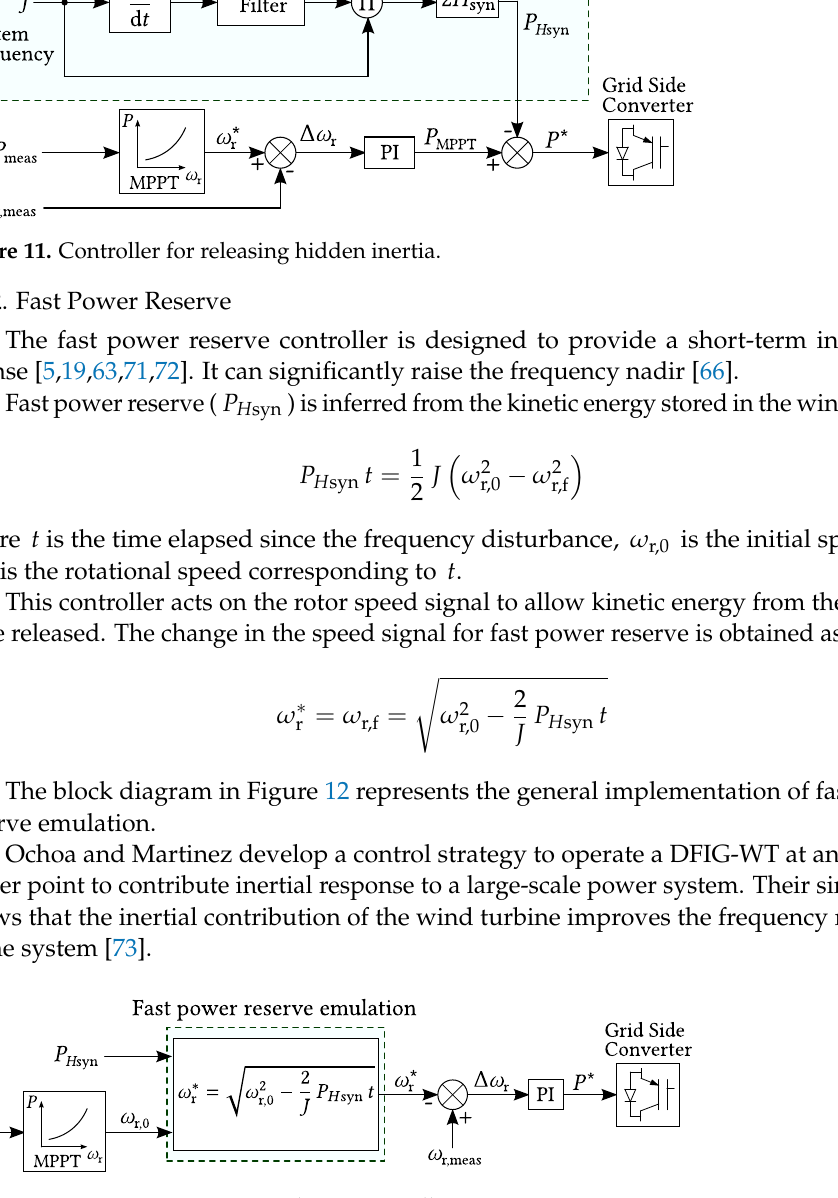
Figure 12. Fast power reserve emulation